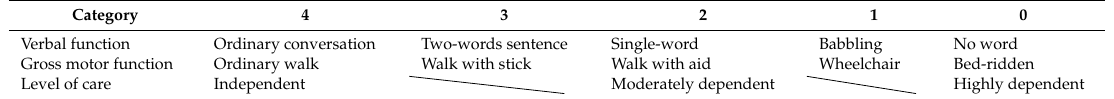
Table 2. Scoring table for activity of daily living (ADL) in patients with MPS